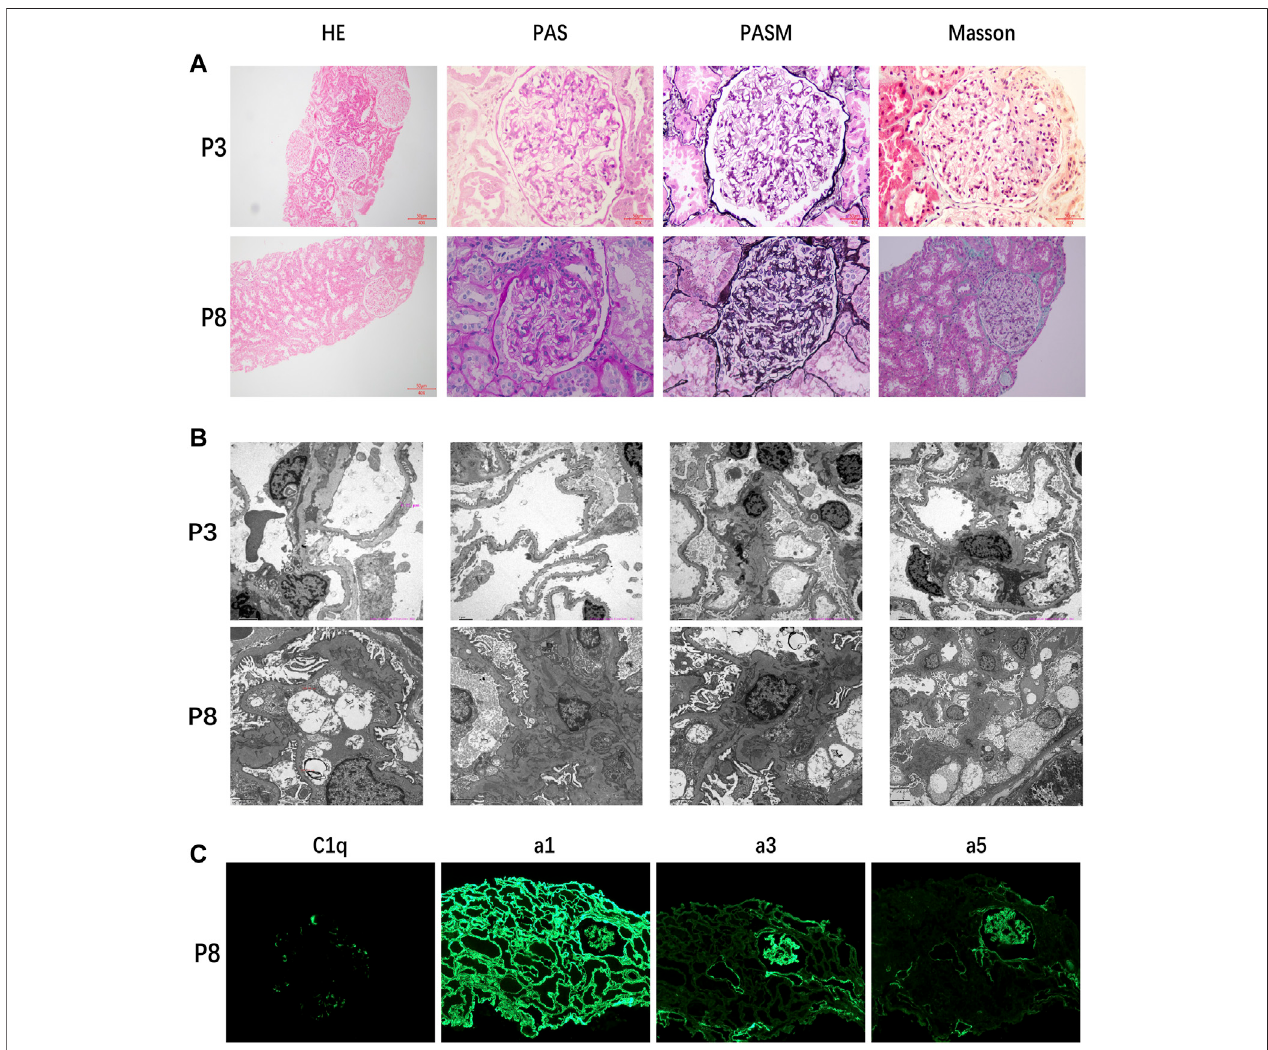
FIGURE 1 | (A) Kidney histological examination of patient 3 showed FSGS and that of patient 8 showed mild proliferation of mesangial cells and stroma. (B) Electronmicroscopicresultsofpatient3stillsupportedFSGSandthoseofpatient8showedhigh-densityelectron-densedeposition. (C) Resultsofimmuno fl uorescence of patient 8 indicated diffuse high-intensity C1q